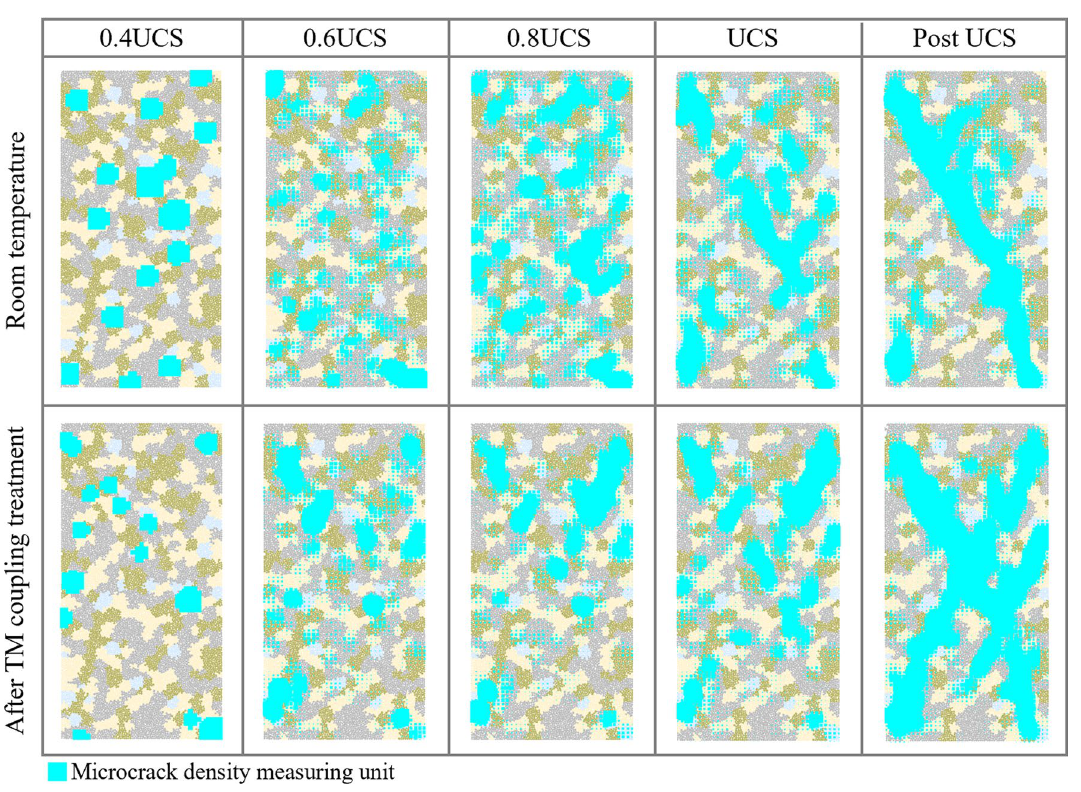
Fig. 10 Microcrack hotspot map of crack propagation path under uniaxial compression simulation